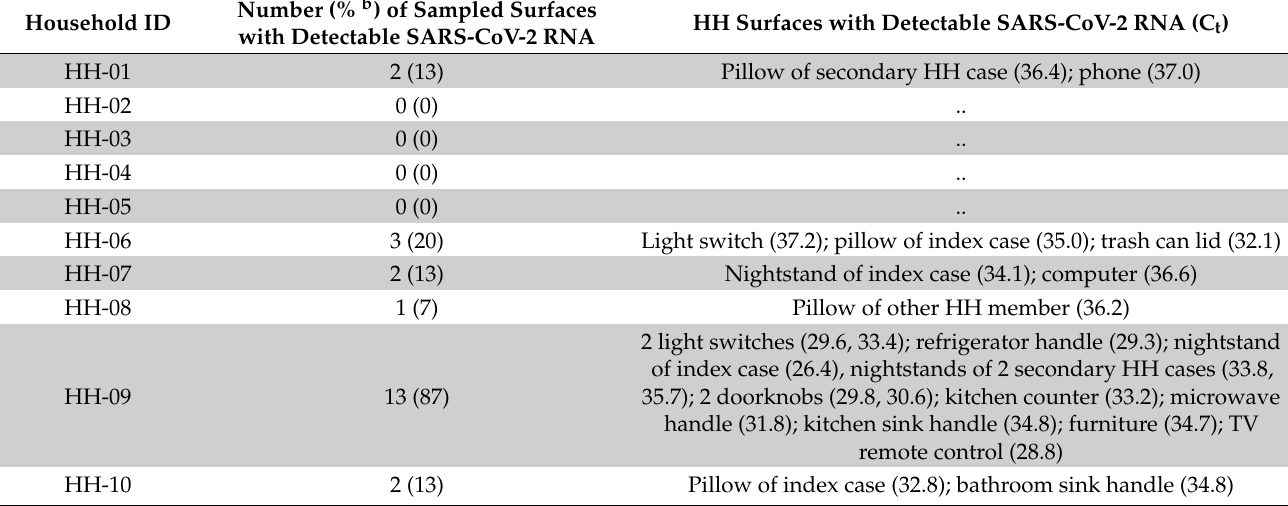
Table 1. Location and cycle threshold (Ct) a value of SARS-CoV-2 detected at environmental surfaces sampled in each of ten households (HHs) with ≥ 1 laboratory-confirmed case of